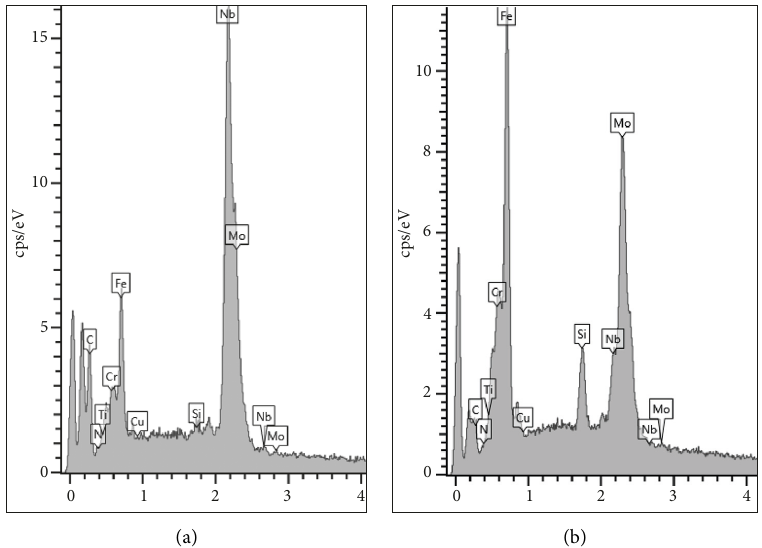
Figure 7: The EDS results of representative precipitated phase for the solution-treated samples after a fire treatment: (a) χ -phase, (b) σ -phase.